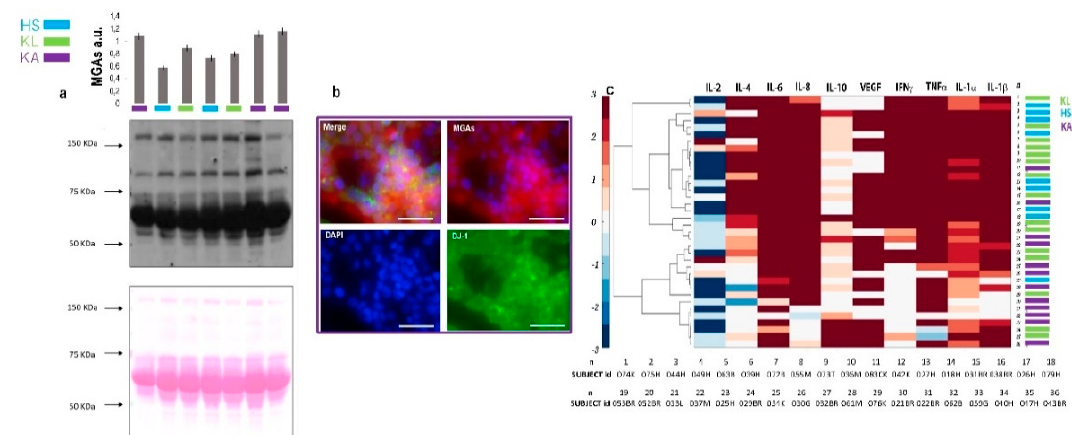
Figure 1. Blood-derived cultures and secretome characterization. The top panel describes an experimental workflow starting from the blood sampling up to the secretome characterization. H&E stained cytological preparations, were prepared from the blood-derived cell cultures (BDCs) derived from samples collected by healthy volunteers and cancer patients in different stages of two reported cases of breast cancer. The cultured cell population was analyzed for the expression of CD45 to evaluate the in vitro hematological (CD45 + ) and non-hematological (CD45 - ; Pan-CK + ) compartment of the cells isolated and expanded. Immunofluorescence for the expression of Pan-CK in an advanced case of breast cancer was reported. The secretome complexity pattern was analyzed with AFM. Secretive vesicles (ranging from 50 to 250 nm in size) in healthy, thyroiditis, and in thyroid carcinoma blood-derived cultures secretome. The distribution density of particles height is plotted with a bin width of 5 nm. The insets show representative images of particles of each population, alongside with height profiles traced through the particles. Scale bars in cytological and immunofluorescence panels correspond to 50 µm.